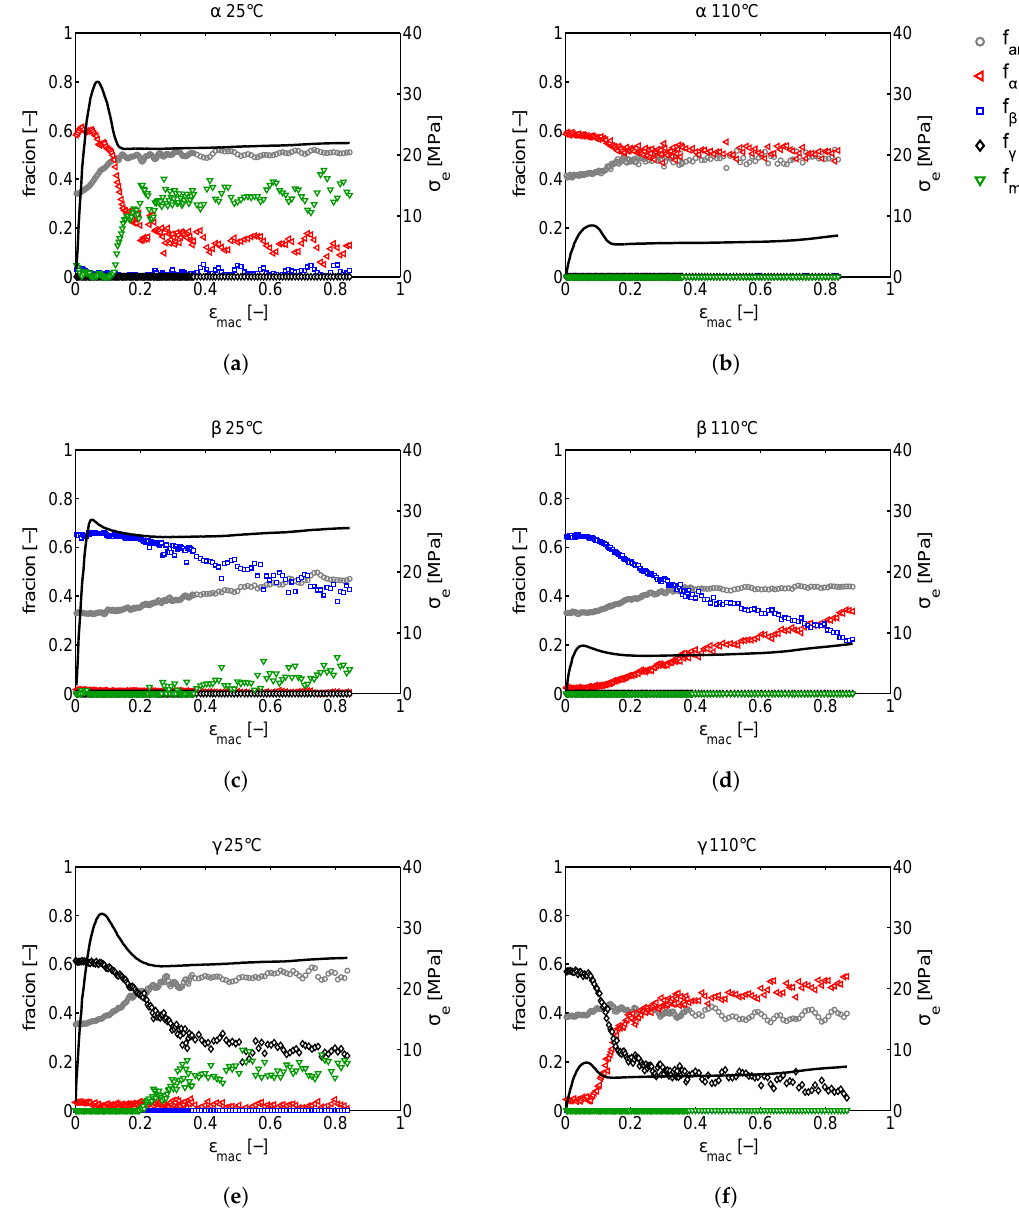
Figure 18. The crystal phase fractions obtained from the WAXD experiments. In ( a , c , e ) we see the evolution of the crystallinity and phase fractions upon stretching at 25 ◦ C. Figure ( b , d , f ) show the result of the tensile experiments performed at 110 ◦ C. From top to bottom we see α -, β - and γ -iPP. The solid lines are the macroscopic engineering stress as a function of the apparent macroscopic